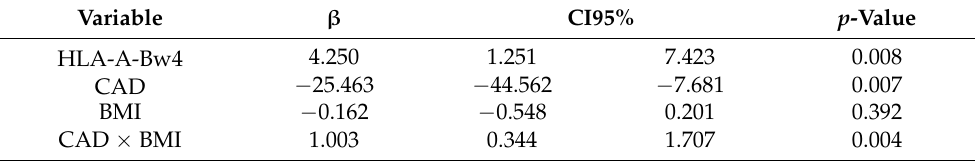
Table 5. Variables related to AAA diameter. Results of regression